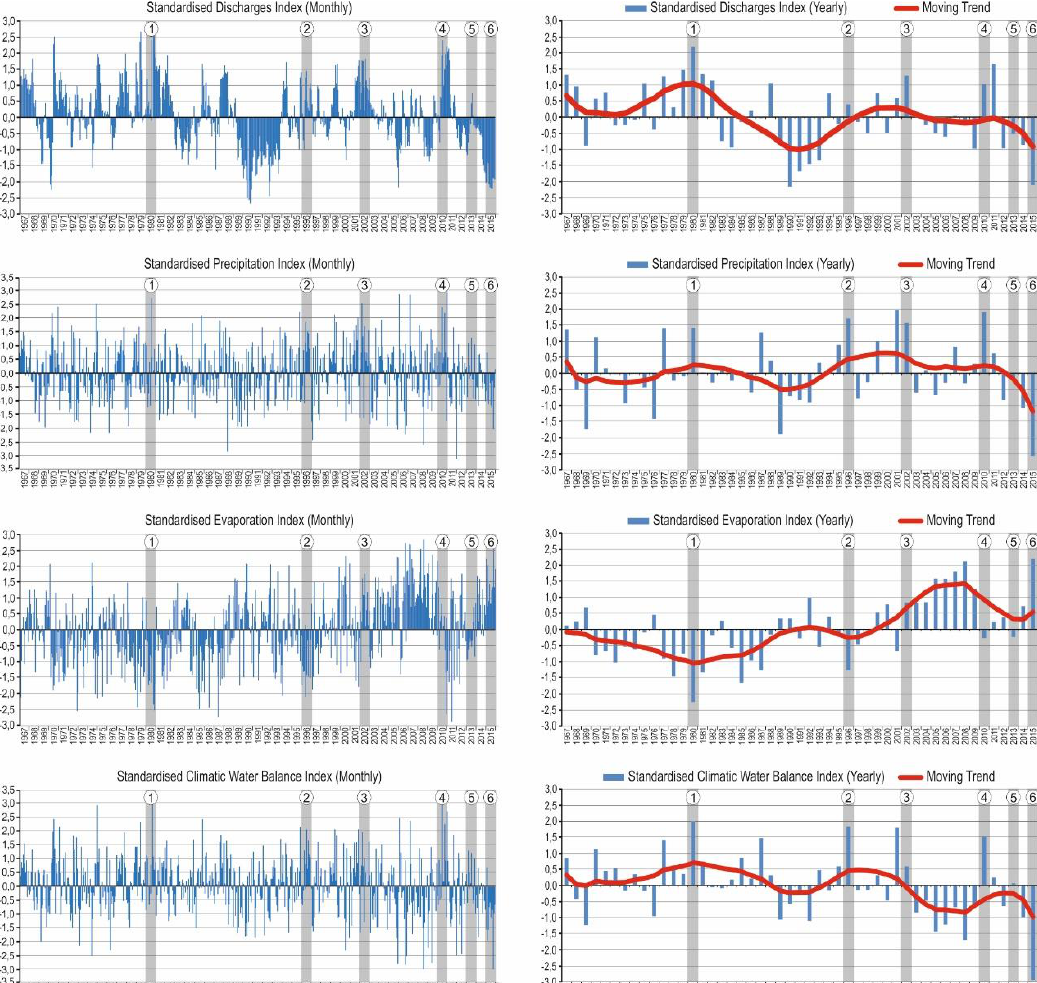
Figure 5. Values of monthly and yearly indices with the moving trend for the latter in the period 1967–2015. The selected periods (months and years) correspond to the satellite images depicted in Figure 6.